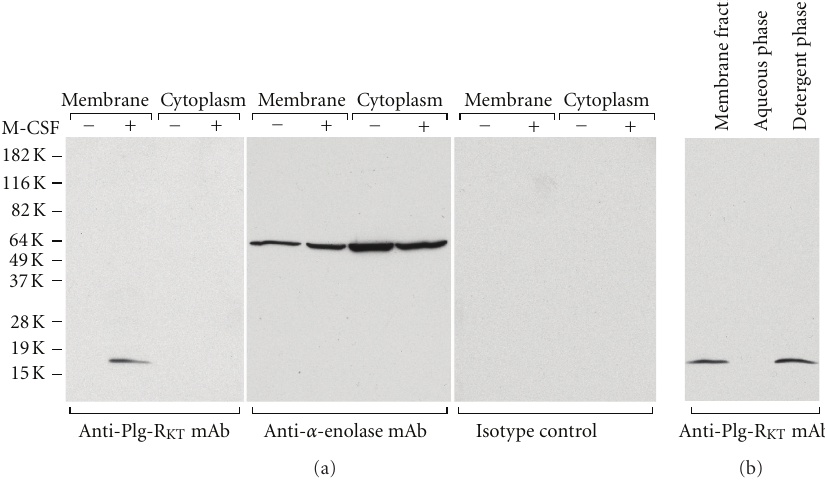
Figure 3: Plg-R KT behaves as a regulated integral membrane protein. (a) Membrane fractions or cytoplasmic fractions from either undi ff erentiated or M-CSF-treated Hoxa9-ER4 cells were electrophoresed on 12% sodium dodecyl sulfate polyacrylamide gels under reducing conditions and western blotted with either anti-Plg-R KT mAb, anti- α -enolase mAb as a loading control, or isotype control mAb. (b) M-CSF-treated Hoxa9-ER4 cell membranes were solubilized in 3% Triton X-114. After heating at 37 ◦ C and separation of the phases by centrifugation, an aliquot of both phases was electrophoresed and western blotted with anti-Plg-R KT mAb. This research was originally published in